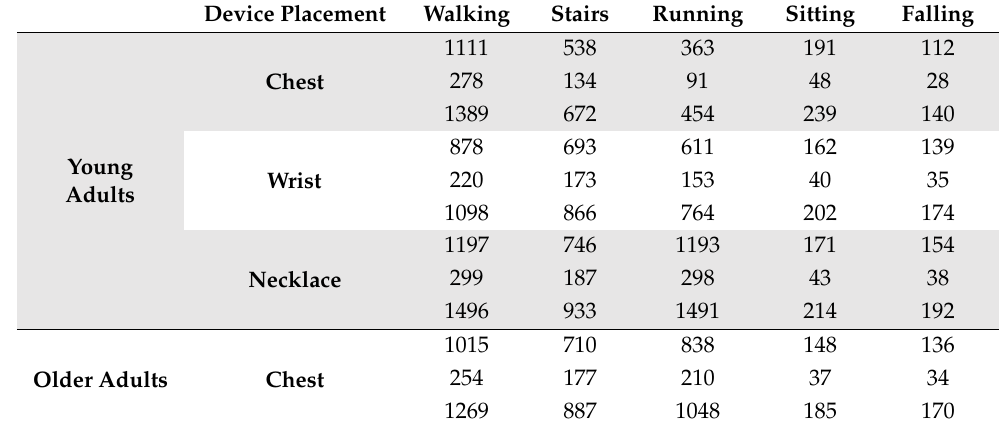
Table 1. Overall description of the dataset collected from different body locations of young and older adults where the SWM device was laminated. Each cell includes train/test/total data points in order. Device Placement Walking Stairs Running Sitting